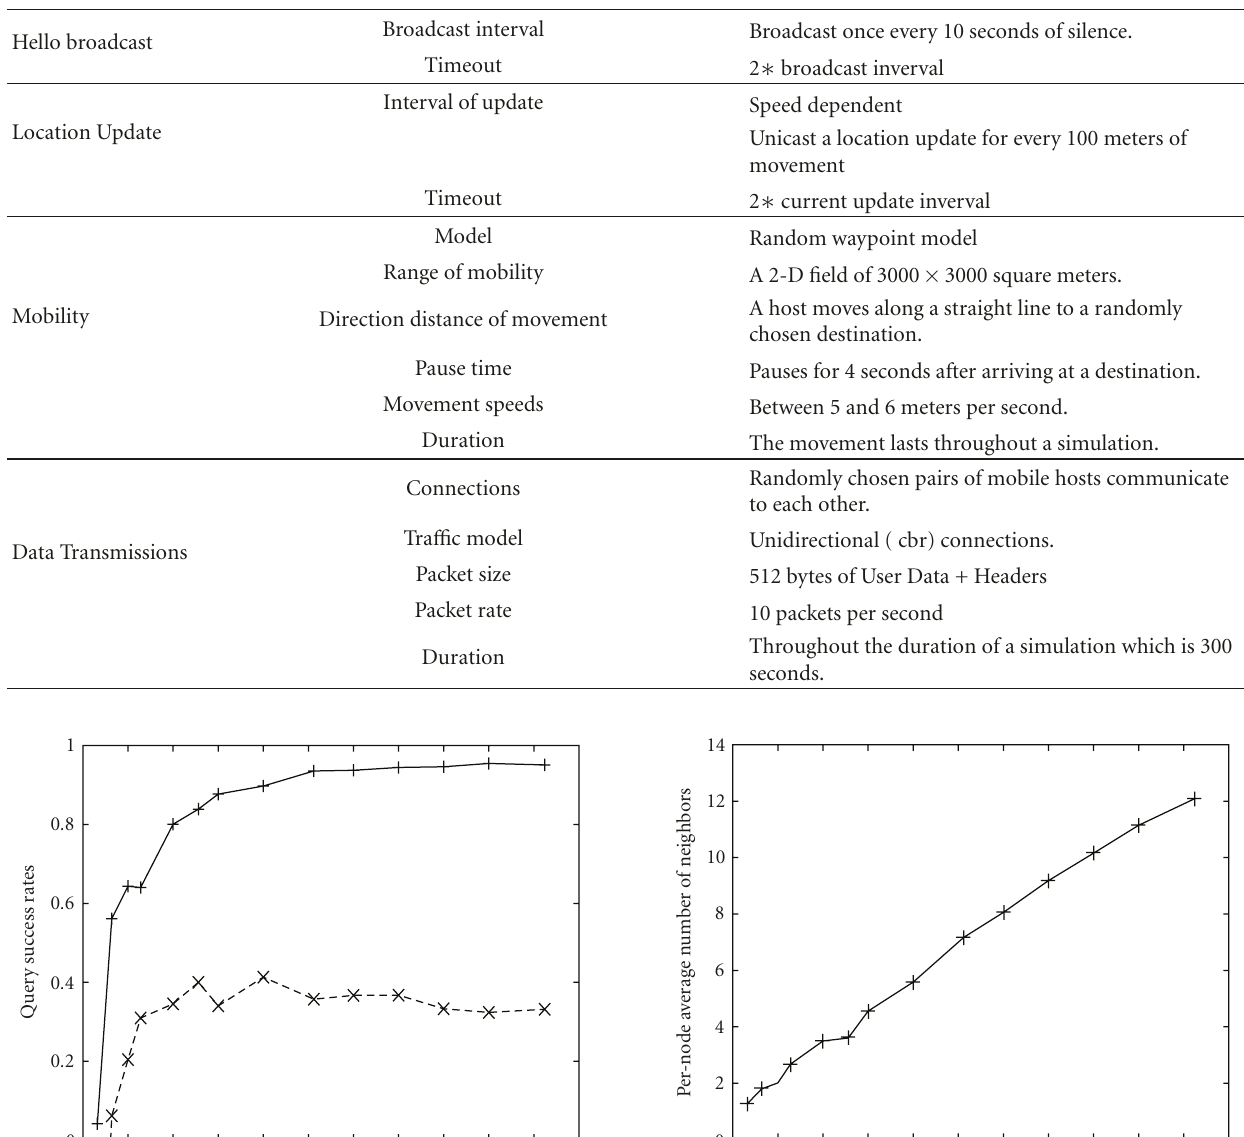
Table 2: The parameters of the PTLS service.